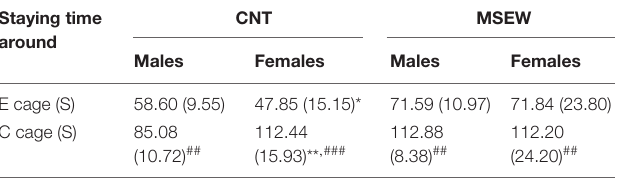
TABLE 2 | Performance of adult rats in social interaction